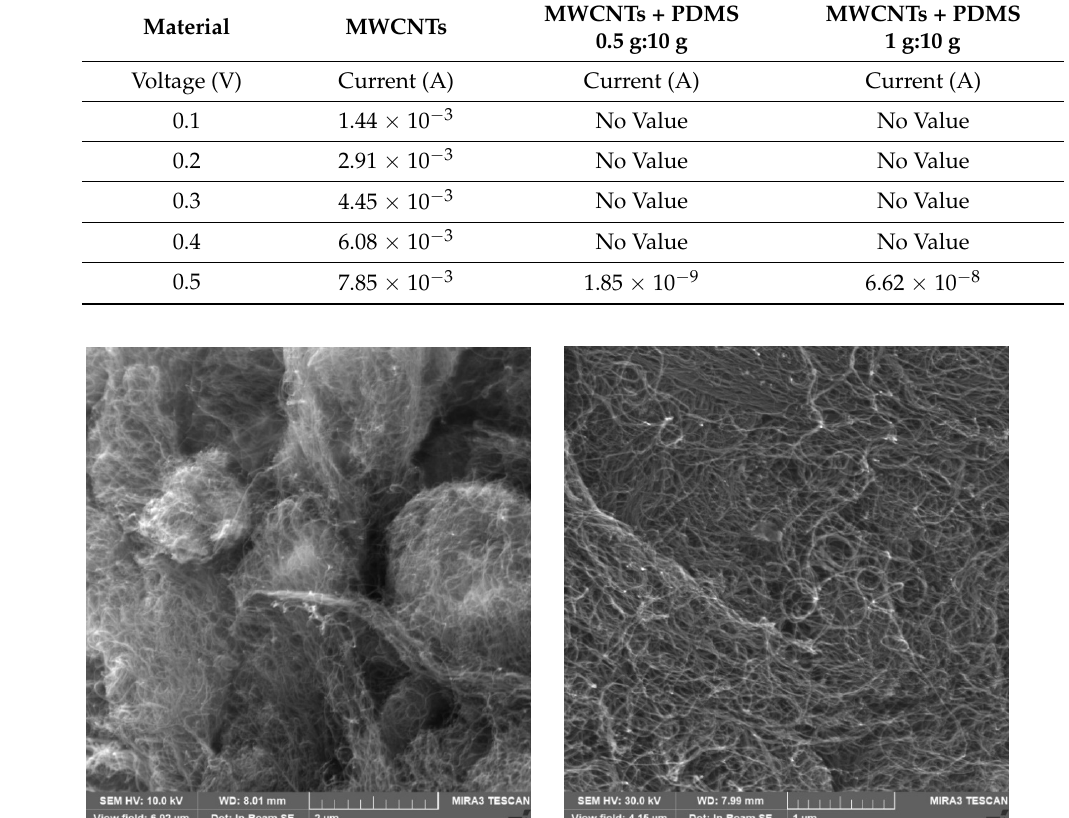
Table 1. Conductivity data of MWCNTs for created in Microfluidic chip.